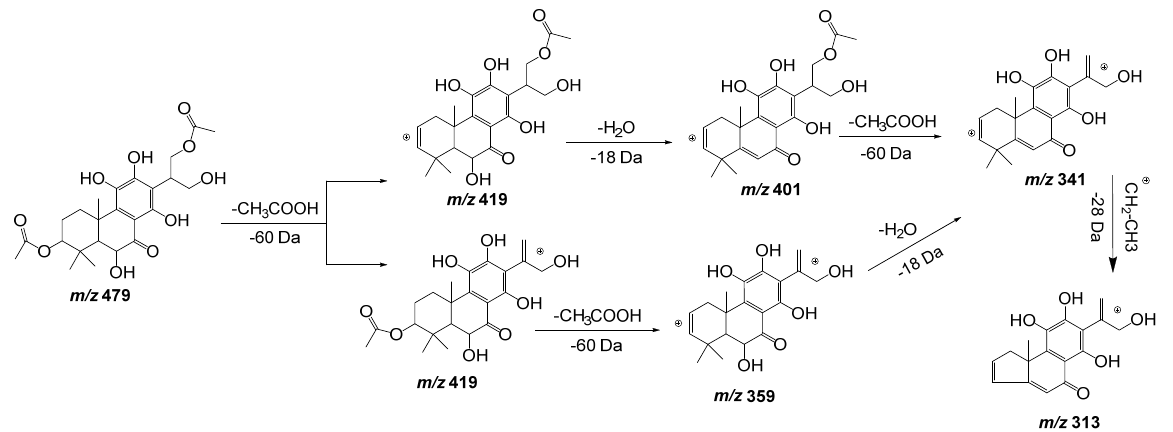
Figure 6. Fragmentation pathway (ESI negative mode) proposed for compound 11 : 6,11,12,14,18- pentahydroxy-3,17diacetyl-8,11,13-triene-7-one. Compound 15 fragments suggest a water molecule (18 Da) trans -elimination fol- lowed by the loss of a carboxyl group (44 Da), respectively. The additional loss of 162 Da indicates the presence of a hexose unit. This fragmentation pattern, the FBMN analysis, and the chemotaxonomic information available for Plectranthus genus allow us to tenta- tively identify compound 15 as hexosyl-6 β -hydroxicarnosol. The aglycone 6 β -hydroxicar- nosol has already been reported for Plectranthus barbatus [28]. The unfavored loss of the hexosyl group is associated to the steric hindrance provoked by 7,20-epoxyabieta-20-one moiety, being consistent with the β position. Compound 16 seems to have a similar backbone as compounds 6 and 7 but with an additional double bond. The fragments suggest the same sequence of fractionation with the loss of H 2 O ( − 18 Da), CH 3 COOH (-60 Da), H 2 O ( − 18 Da), and at last CO ( − 28 Da). This information allows us to identify compound 16 as 3,6,11,12,14-pentahydroxy-2-acetyl- 5,7,11,13-abietatetraen-7-one. Similar compounds have been isolated from P. madagascari- ensis [27] and P. scutellarioides [24]. Compound 17 shows a pseudomolecular ion at m/z 477.1798 [M-H] – corresponding to the molecular formula C 24 H 30 O 10 , being similar to compound 11 but with an extra dou- ble bond. Figure 7 shows the fragmentation pathway proposed for this compound. This metabolite has been previously isolated from P. scutellarioides [24]. Figure 7. Fragmentation pathway (ESI negative mode) proposed for compound 17 : 6,11,12,14,16- pentahydroxy-3,17diacetyl-5,8,11,13-tetraene-7-one.